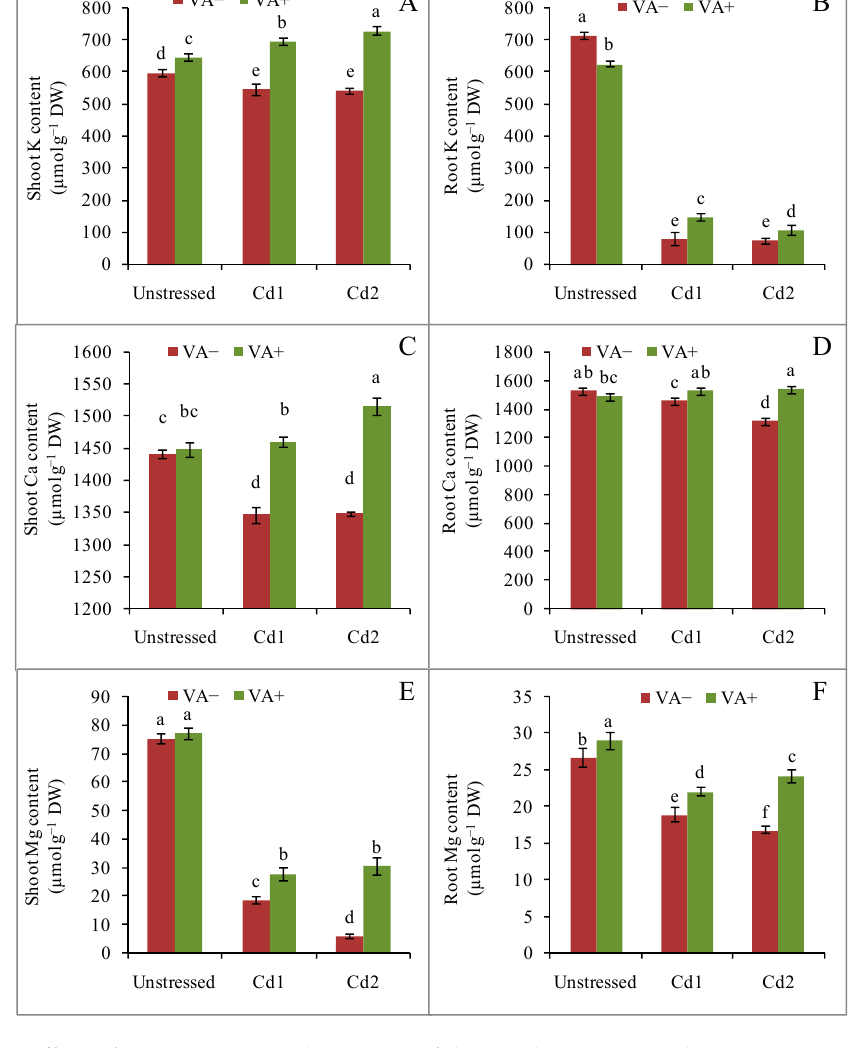
Figure 8. E ff ects of exogenous VA on the contents of shoot and root K, Ca, and Mg(( A ) shoot K; ( B ) root K; ( C ) shoot Ca; ( D ) root Ca; ( E ) shoot Mg; ( F ) root Mg) of rice seedlings under Cd toxicity stress. Mean ( ± SD) was computed from three replications of each treatment. Bars with dissimilar letters are significantly di ff erent at p ≤ 0.05 from Fisher’s least significant di ff erence (LSD)